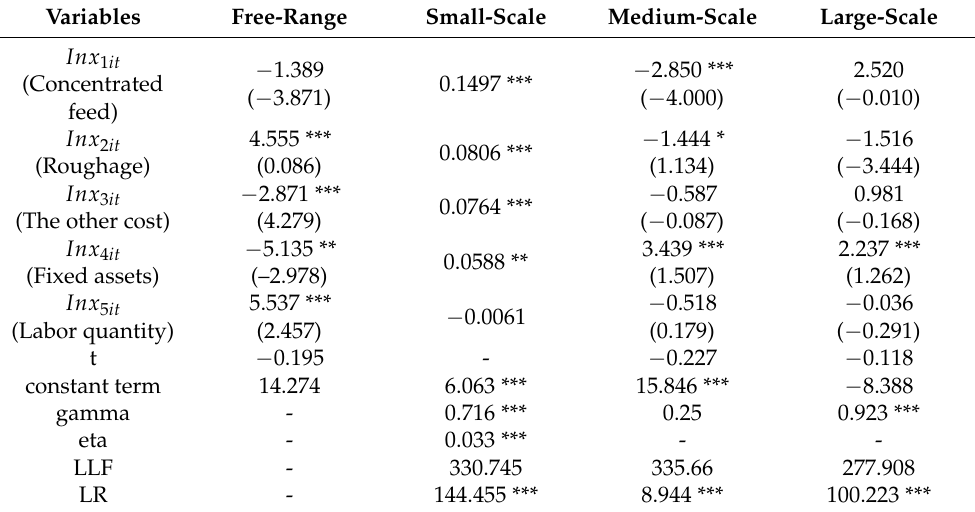
Table 4. Parameter estimation and test of the single terms of SFA